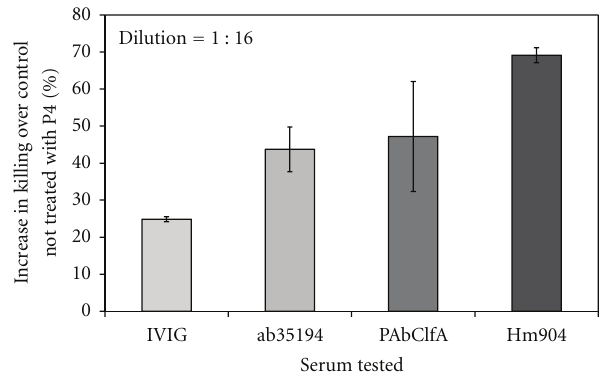
Figure 1: P4-mediated enhancement of in vitro opsonophagocytic killing of Staphylococcus aureus strainN. In vitro opsonophagocy- tosis killing assay was performed with HL60-cells-derived granulo- cytes. Addition of P4 increased the opsonophagocytic killing of S. aureus strainN in the presence of strain-specific antibodies. Maxi- mum enhancement ( ≥ 70%) was seen with HM904 over control that had all OPKA components except P4 ( P < 0 . 05). Antibodies